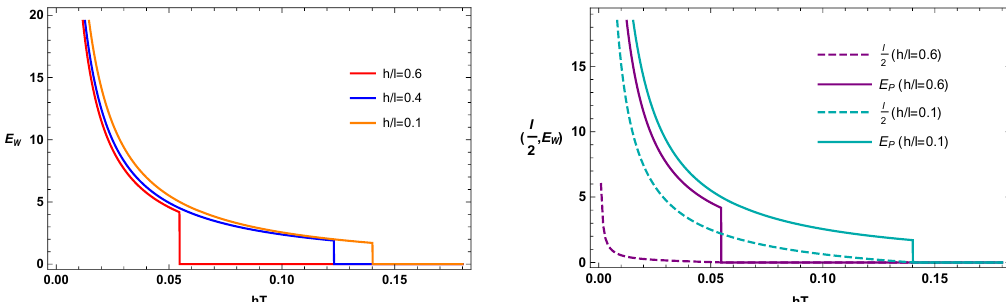
Figure 6 . Left : E W as a function of hT for di(cid:11)erent values of h=‘ in d = 2. In all these cases E W undergoes a discontinuous phase transition beyond which it is identically zero. Right : checking I= 2 E W . Here we set H=G N = (cid:20)